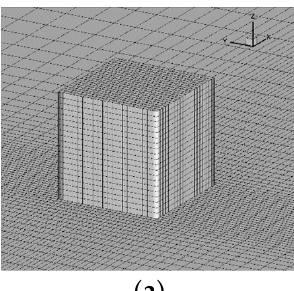
Figure 2. Computational domain and boundary conditions.